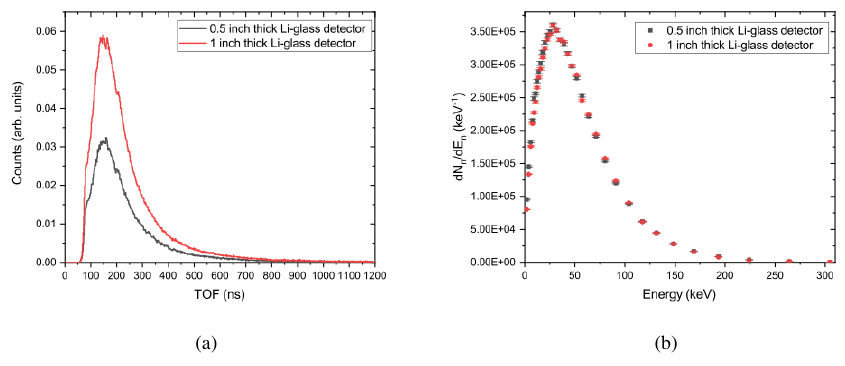
Figure 3. a) Angle-integrated neutron time-of-flight (TOF) spectrum, obtained by summing the weighted TOF spectra from 10 up to 90 degrees for each detector. b) Angle-integrated neutron energy spectrum obtained with the new conversion method.